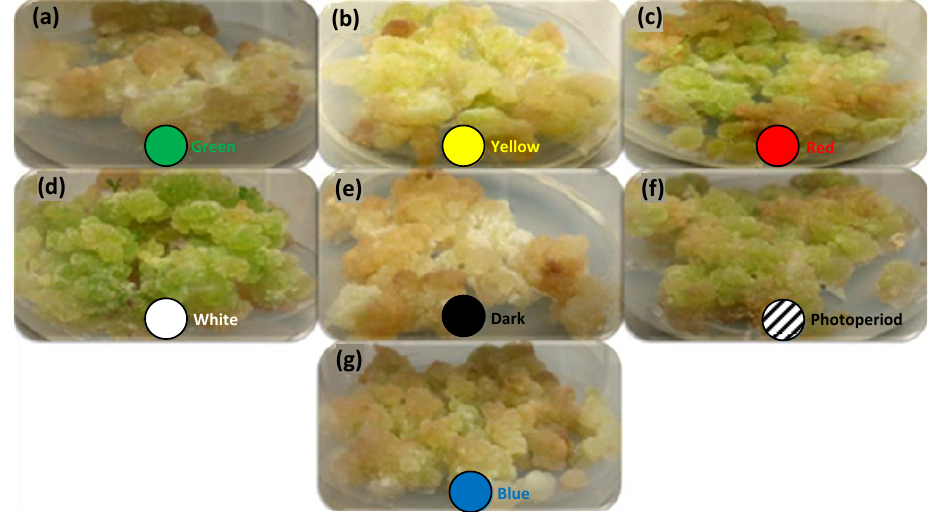
Figure 3. Representative effects of monochromatic lights on morphology of leaf explant-derived callus cultures of S. xanthocarpum grown under different monochromatic lights conditions after 35 days of cultivation.